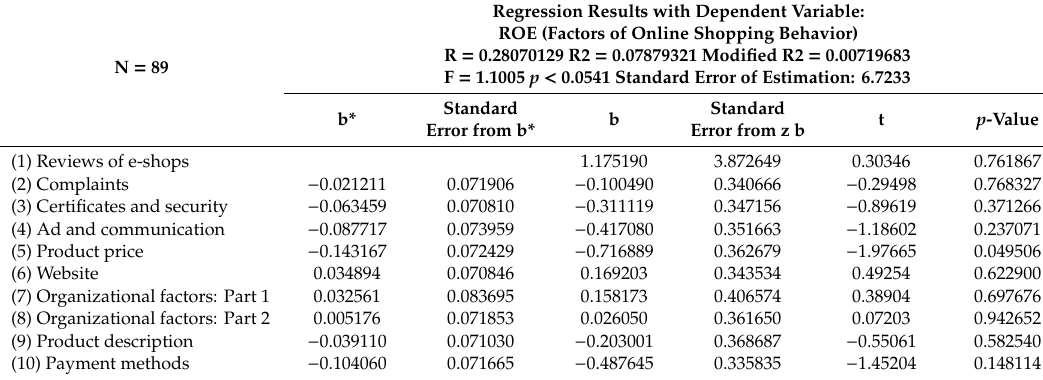
Table A3. Multiple regression between ROE and factors of online shopping behavior. Source: own processing (in the Statistica